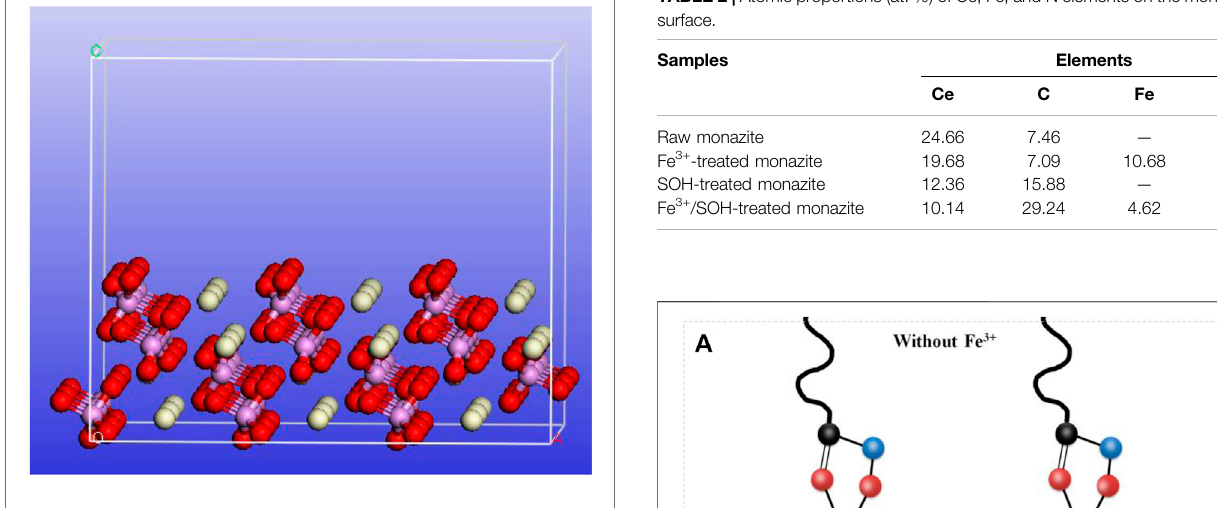
FIGURE 10 | Schematic diagram of the 3 × 3 supercell of the monazite crystal with the (100) cleavage (top view) being cut.